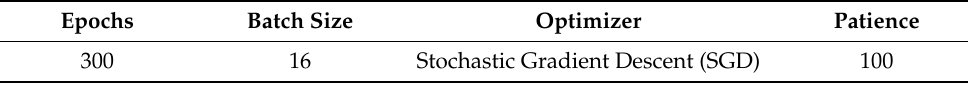
Table 3. YOLOv5 insect trap image